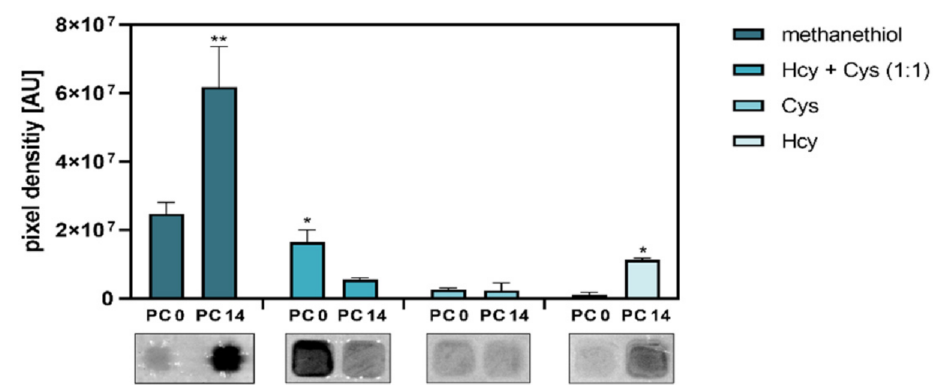
Figure 5. The capacity to produce H 2 S from methanethiol and cysteine analogues is differently affected by the spontaneous differentiation of Caco-2 cells, reflecting concomitant alterations of H 2 S-producing enzymes. Lysates of undifferentiated (PC 0) and terminally differentiated (PC 14) cells were incubated with substrates for H 2 S production (methanethiol, homocysteine (Hcy) and/or cysteine (Cys)) as indicated. Three independent experiments were performed, with one representative result shown for each substrate (lower panel). Pixel density of the obtained PbS spots was determined by densitometric analysis; the data represent means ± SD (upper panel). Statistical significances were calculated using Welch’s t -test, with p < 0.05 (*) and p < 0.01